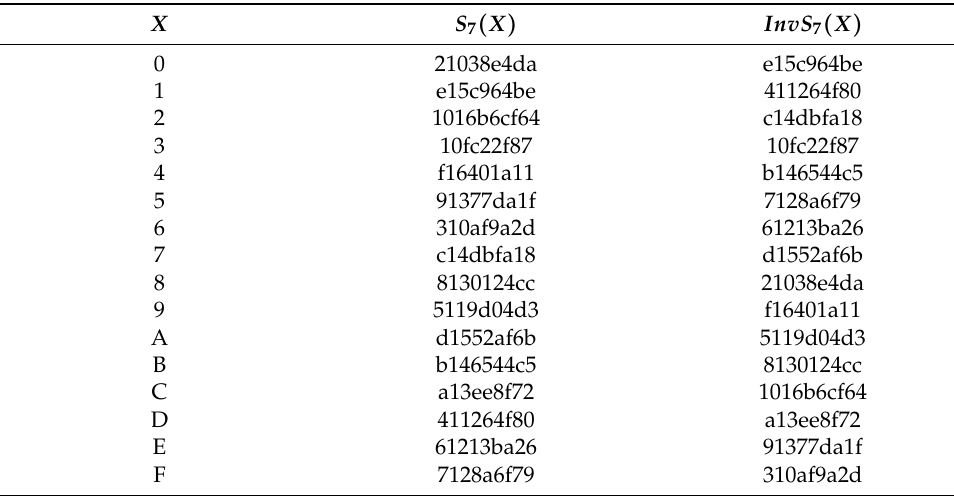
Table 17. New Generated 32-bit output S-Box to replace Table